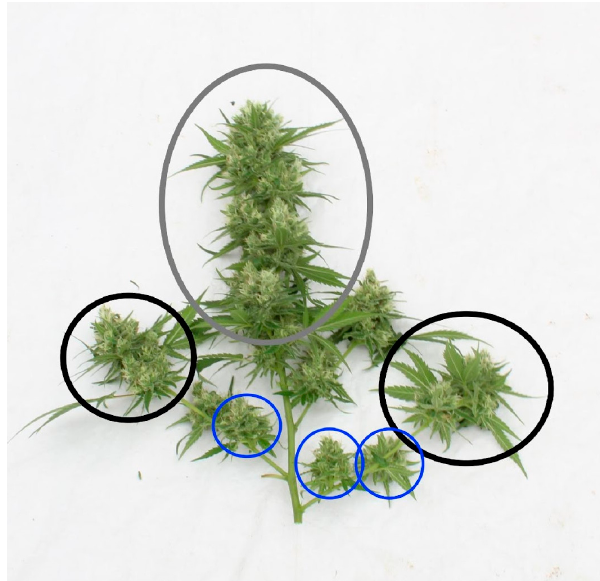
Figure 1. A reproductive portion of a mature C. sativa “BaOx” plant at 8 weeks of reproductive growth after induction of the critical night length (CNL). This portion of the plant consists of the upmost three secondary branches and the shoot apical meristem (SAM) floral raceme (shown in the singular grey oval). The secondary axillary terminal racemes are observed as the two floral structures circled in black. Finally, the three blue circled floral structures are the interior buds. Note that all floral structures are determinate at the nodes.